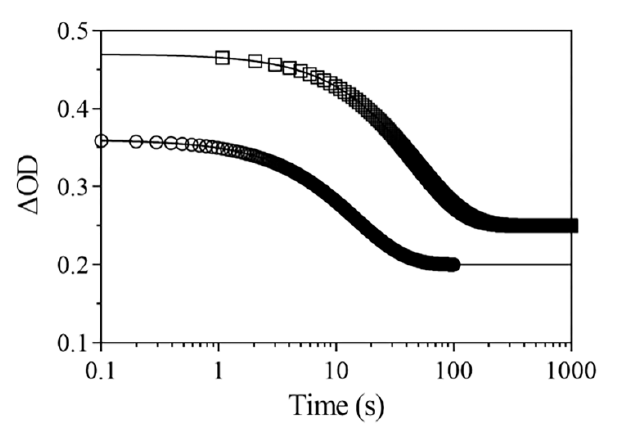
Figure 9. NO dissociation from Mt -Nb(II)-NO (circles) and Hs -Nb(II)-NO (squares) by CO replace- ment, λ = 420 nm, pH 7.0 and 22.0 ◦ C. The continuous lines were obtained according to Equation (1) with values of k off(NO) reported in Table 1. R -squared values for NO dissociation from Mt -Nb(II)-CO and Hs -Nb(II)-CO are 0.999 and 0.999, respectively.